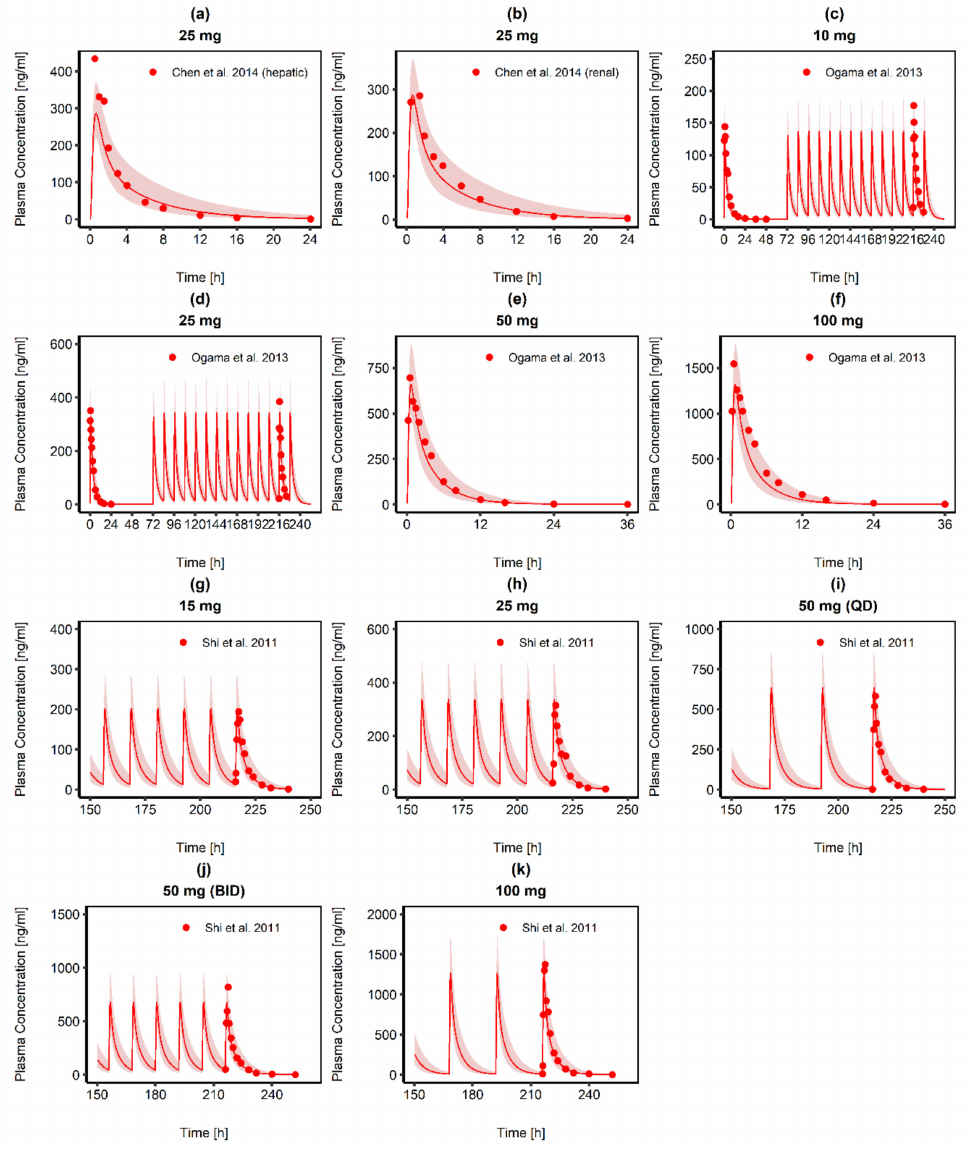
Figure 2. Predicted RUX plasma concentration-time curve profiles (solid red lines) and observed RUX concentrations (red dots), obtained after single ( a , b , e , f ) and multiple RUX tablet ( c , d , g – k ) administra- tion. The red shaded area represents the predicted population geometric standard deviation in each case. The ESM contains detailed information about the study protocols and RUX model performance for each simulation. QD: once daily, BID: twice daily. Source: